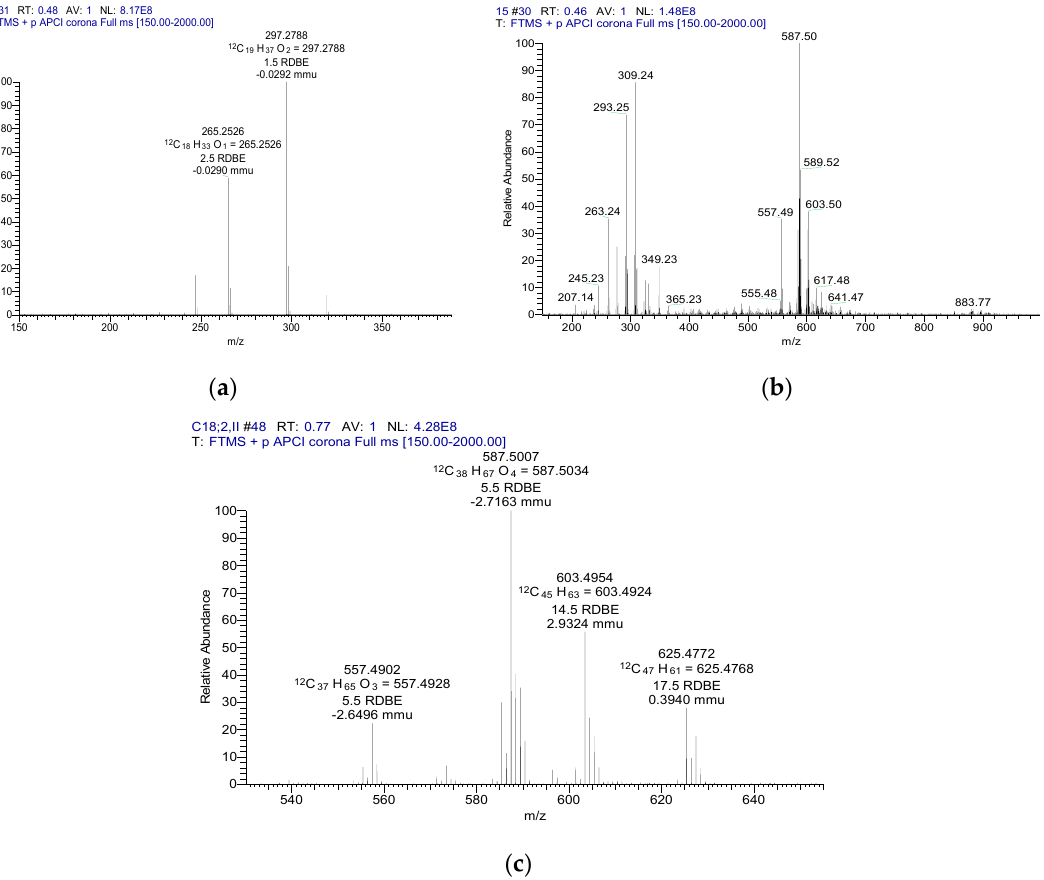
Figure 7. High performance liquid chromatography-atmospheric pressure chemical ionization mass spectrometry (HPLC-APCI MS) spectra for the fresh and polymerized linoleic acid (C18:2) methyl ester. ( a ) Fresh linoleic acid (C18:2) methyl ester; ( b ) Polymerized linoleic acid (C18:2) methyl ester; and, ( c ) Expanded spectrum for polymerized linoleic acid (C18:2) methyl ester.